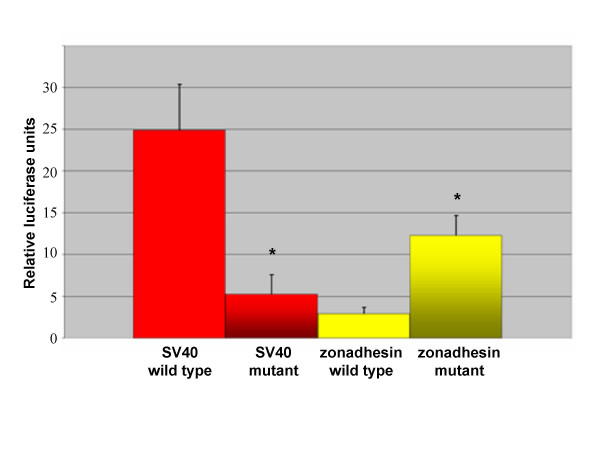
The poly(A) signal is essential for polyadenylation of male germ cell-specific polyadenylation sites. ATCC 3T3 cells (mouse embryonic fibroblasts) were transfected with reporter plasmids containing the indicated polyadenylation cassettes. Bars represent the average relative luciferase activity over three different replications. Asterisks indicate significant difference from the wild type version of each cassette (p < 0.01).